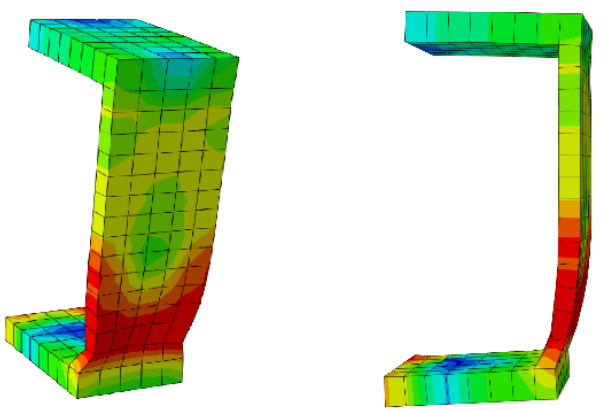
Figure 11. Typical channel connector failure at elevated temperature.